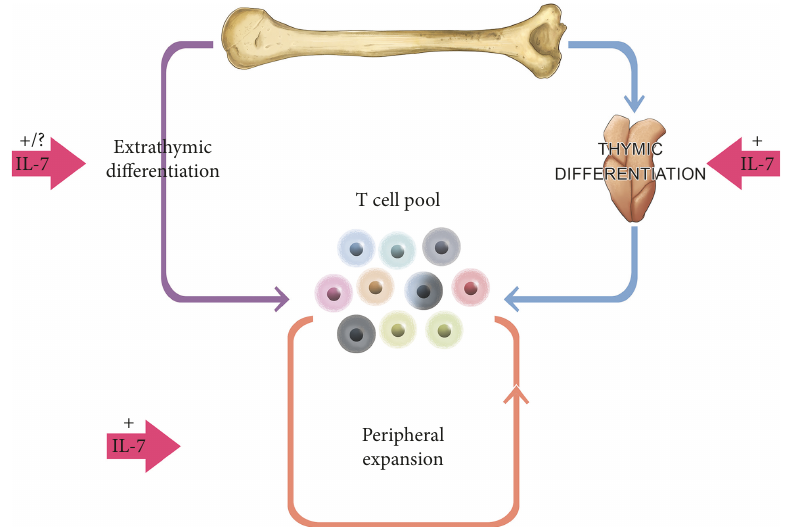
Figure 4: E ff ect of IL-7 on T cell regeneration. IL-7 regulates T cell homeostasis through three immune modulation pathways: thymic di ff erentiation, peripheral expansion, and extrathymic di ff erentiation. To regenerate peripheral T cells, IL-7 directs T cell di ff erentiation and maturation in the thymus. As age-related decline in thymic function becomes apparent, IL-7 contributes to the maintenance of the T cell pool through the expansion of existing peripheral T cells. Extrathymic di ff erentiation from CLP cells is possible but is only a minor pathway. In all three scenarios, IL-7 is known to have an important signaling e ff